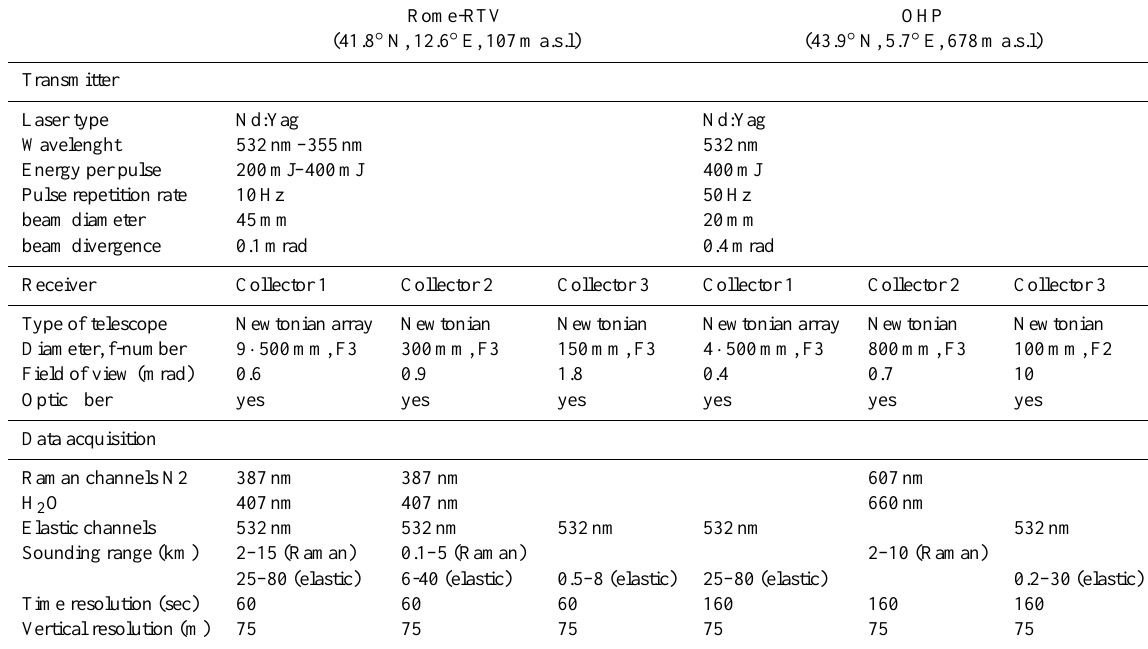
Table 1. Transmitter and receiver characteristics of the OHP and RTV lidar